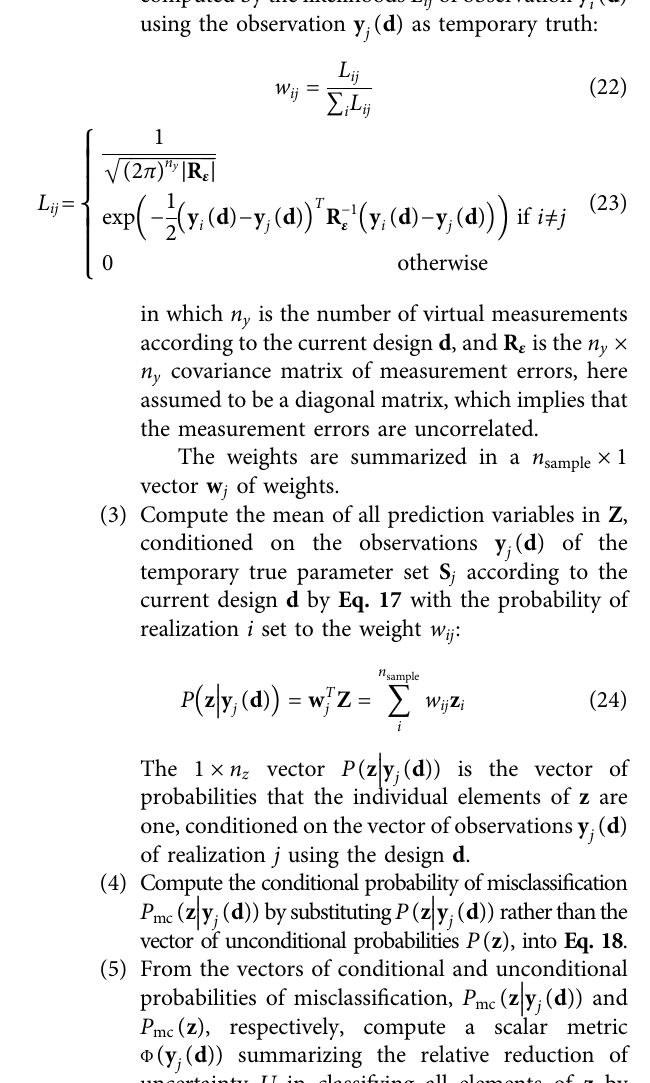
Frontiers in Earth Science |